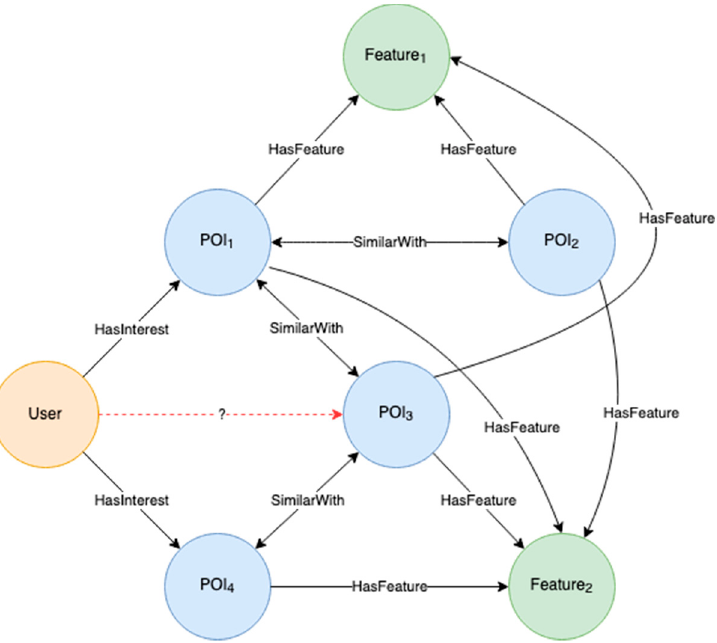
Figure 3. Top level graph schema: finding the interest of a user in POI 3 .